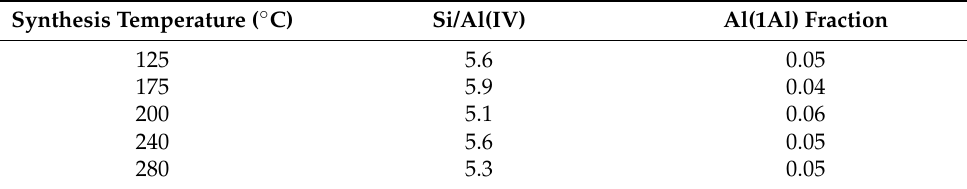
Table 3. Si/Al(IV) ratio and Al(1Al) fraction in the saponite tetrahedral sheets based on 29 Si MAS- NMR resonance